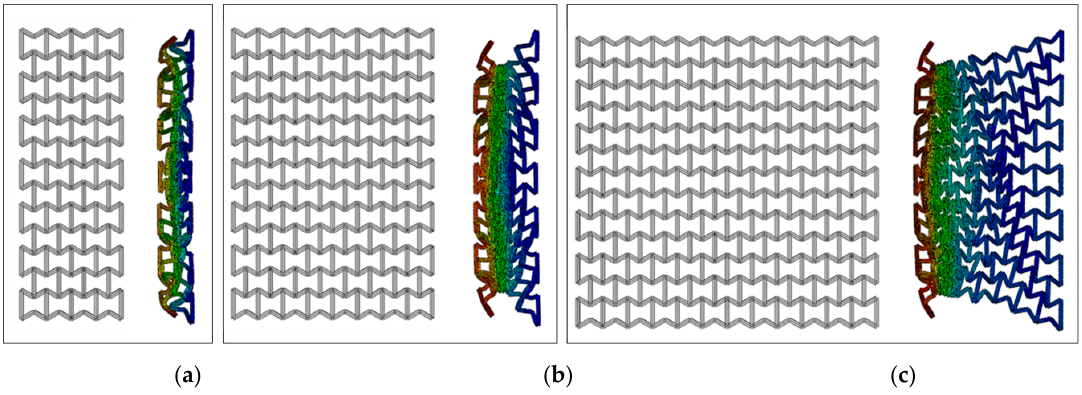
Figure 17. Deformation patterns of three auxetic cores with different numbers of layers of the same geometrical properties and loading conditions, having the same loading direction D1, Grade AL3, Cell dimension B (L = 10 mm), t = 2.6 mm, t / L = 0.26, θ Aux = 60 ◦ , ( a ) four layers, ( b ) eight layers, ( c ) twelve layers.